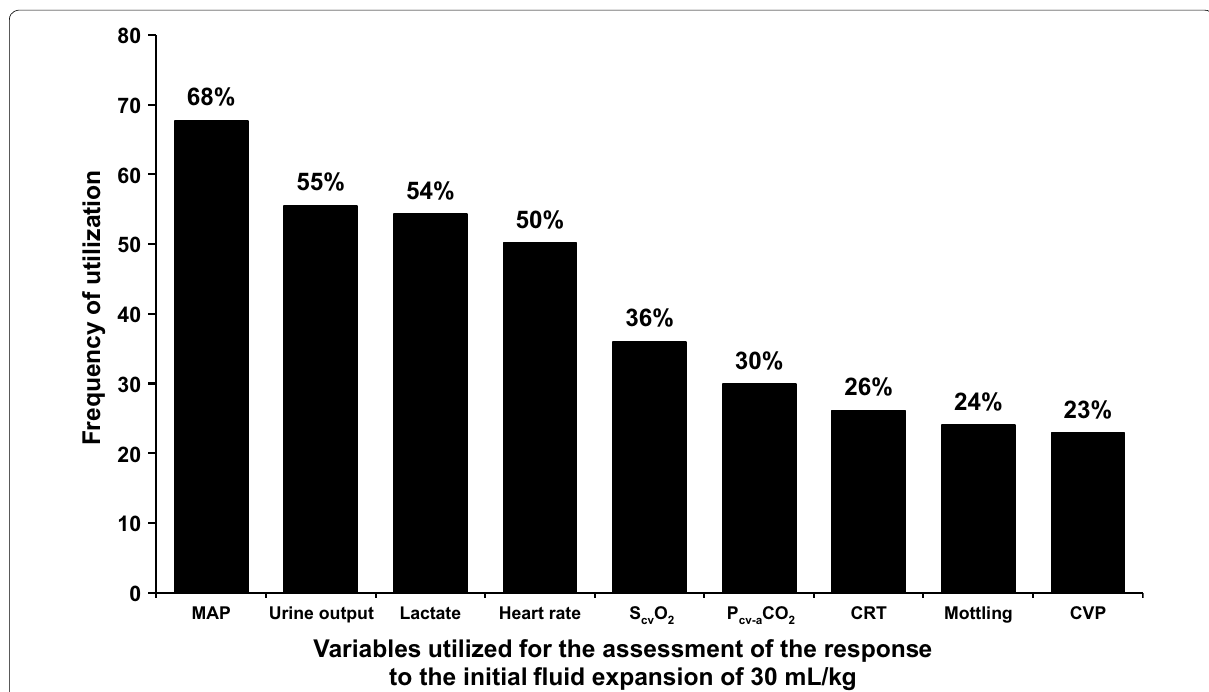
Fig. 2 Frequency of the variables utilized as criteria of hypoperfusion for the assessment of the response to the initial fluid bolus of 30 mL/kg. MAP, mean arterial pressure; S